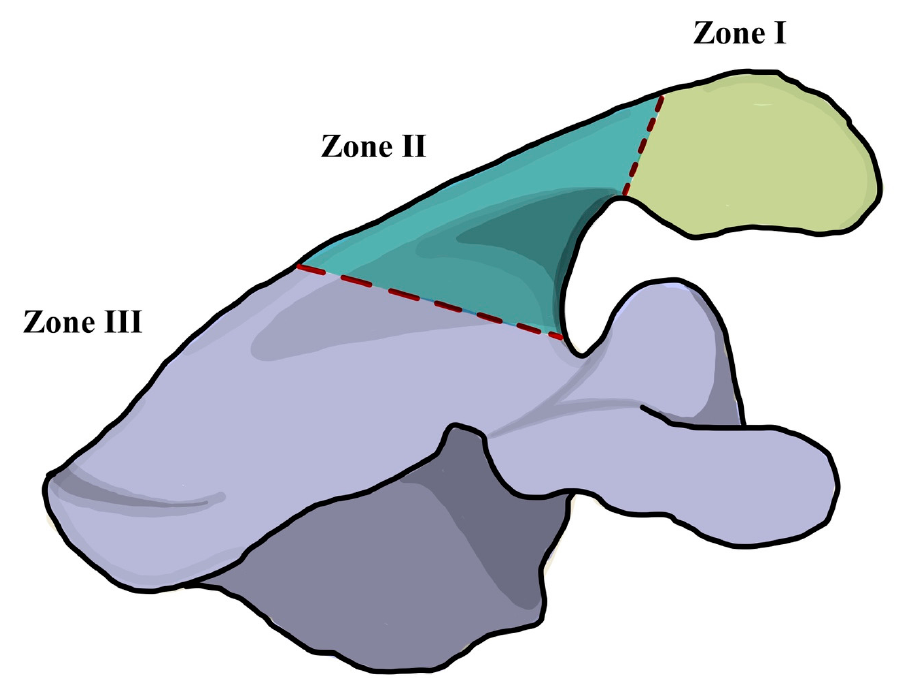
Figure 1. Illustration of the Levy classification for acromial stress fractures after reverse total shoulder arthroplasty [19]. Zone I involves a fracture through the midpart of the acromion caused by the anterior and middle deltoid origin. Zone II was defined as a fracture caused by the entire middle deltoid segment and portion of posterior deltoid origin. Zone III fractures involve the entire middle and posterior deltoid origin.